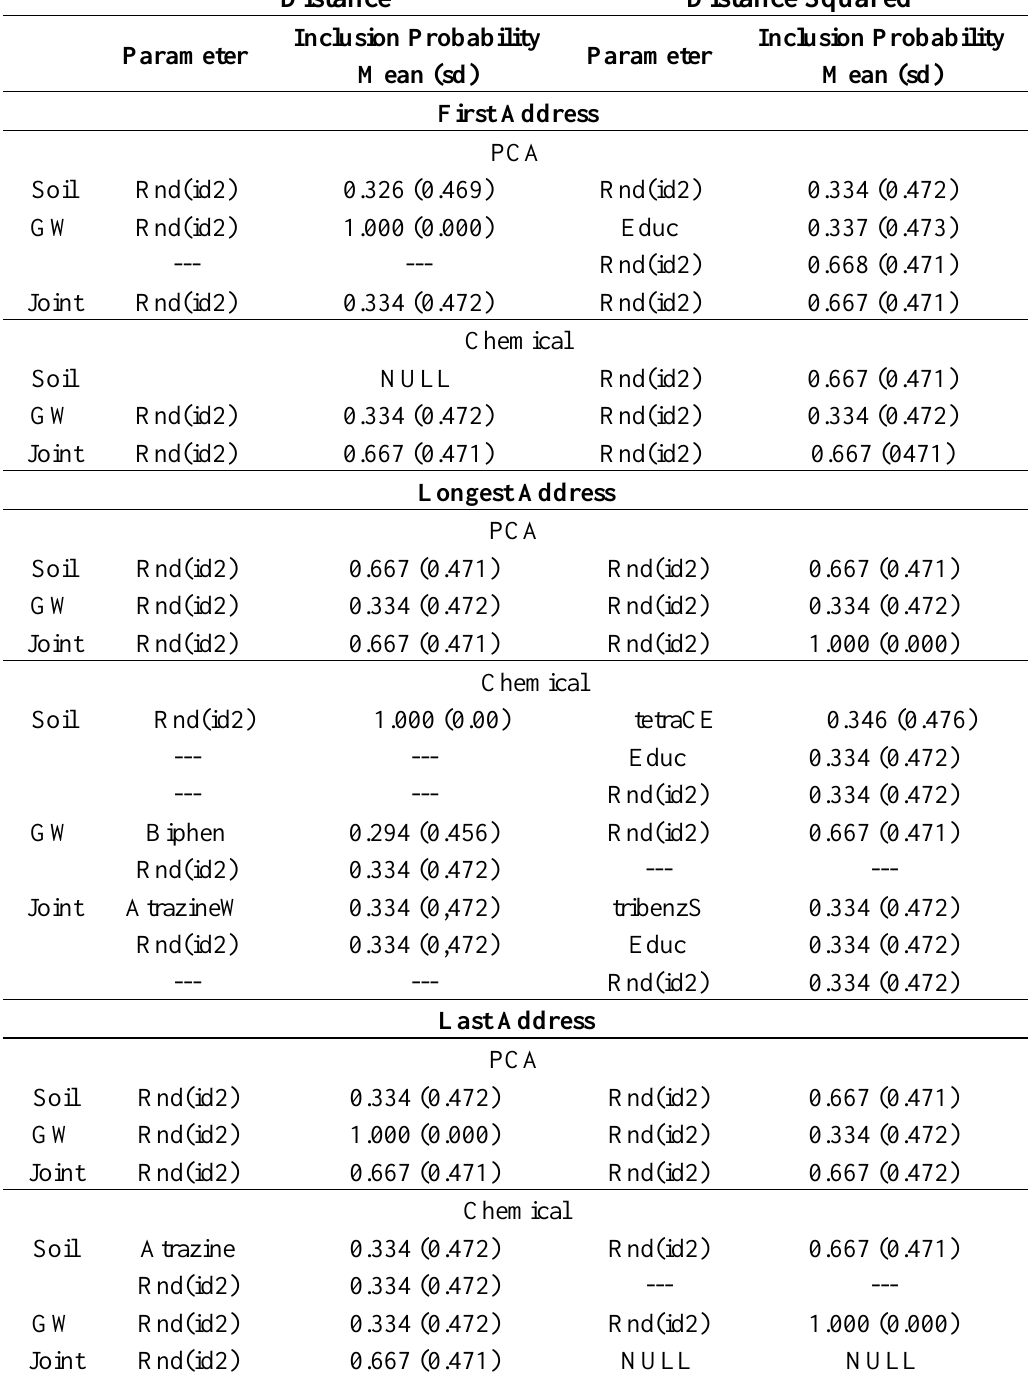
Table 4. The posterior mean and standard deviation of the inclusion probability for variable selection algorithms applied to first, longest, and last addresses presented in that order. Rnd (id2) here indicates the random intercept component of the